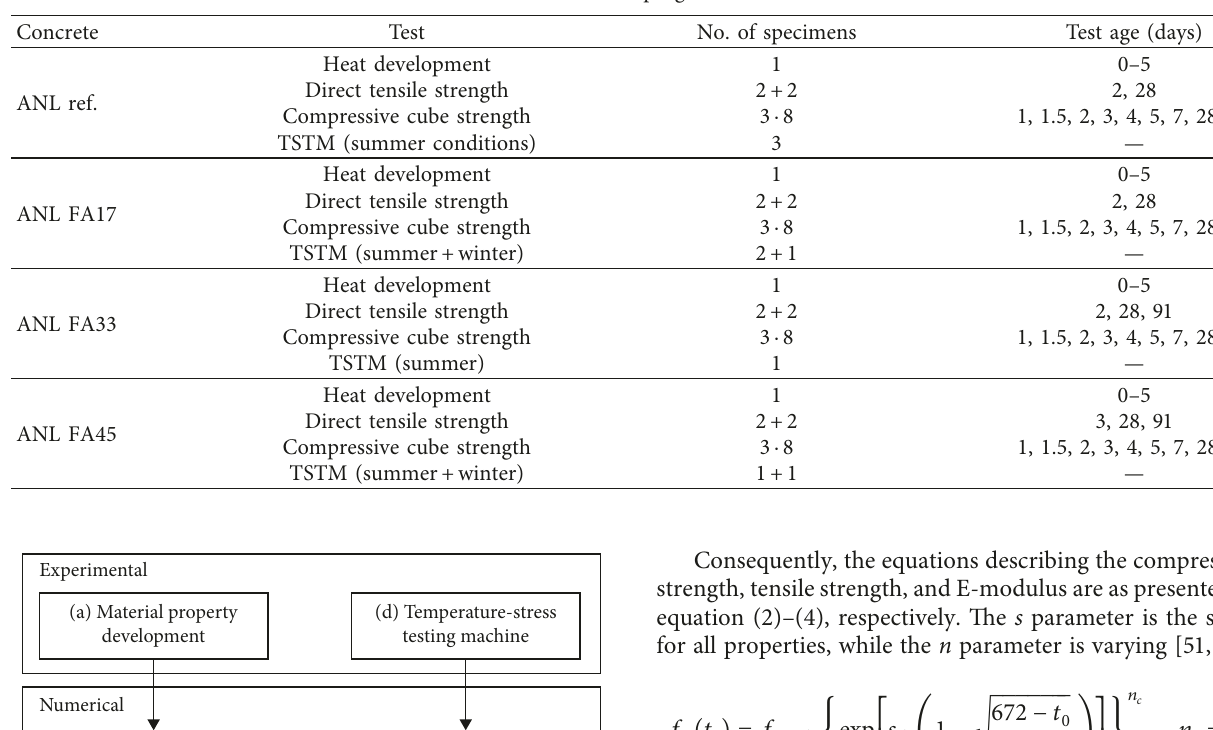
Table 2: Test programme.